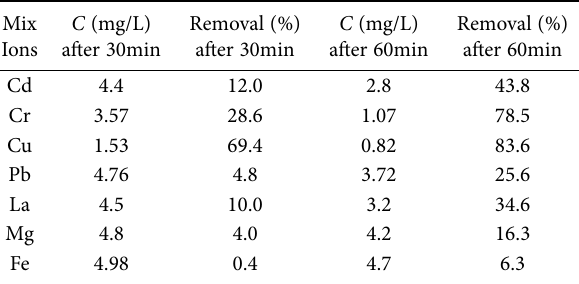
Table 4. A comparison of removal rates observed in a mixture of cadmium, chromium, copper, lead, lanthanum, magnesium, and